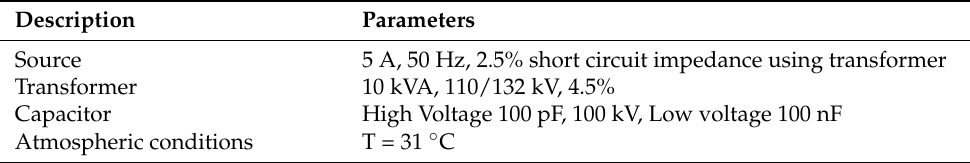
Table 12. Experimental setup